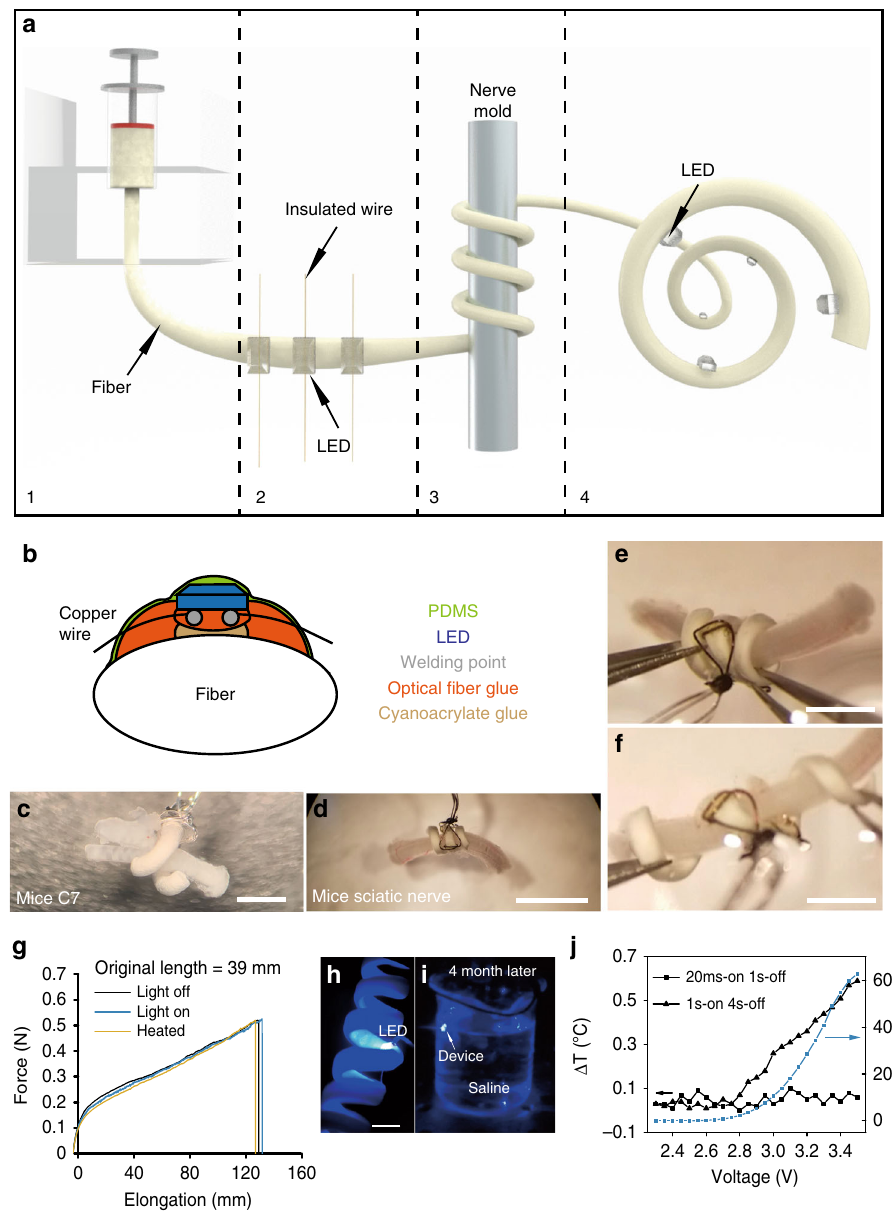
Fig. 2 Fabrication and performance of the multisite optogenetic stimulation device (MOSD). a Flow chart for MOSD fabrication. (1) Production of a polyurethane fi ber; (2) attachment of mini-LEDs to the fi ber; (3) shaping of the fi ber into a spiral shape; (4) fi nal device. b Schematic diagram of device encapsulation. c , d Images of the MOSD wrapped around nerves with different diameters. c Mouse C7 nerve. d Mouse sciatic nerve. e An image of the MOSD at its original length fi xed onto the mouse sciatic nerve. f An image of the elongated MOSD in e . g Mechanical properties of the polyurethane fi ber under light or heat. LED was turned on at 2.5 V, 20.7 µ A (0.0012 mW). The device was kept at 50 °C in the heated condition (green line). The original length of the MOSD is 39 mm. h The MOSD with mini-LEDs turned on in saline. i The MOSD with mini-LEDs turned on after 4 months continuously submerged in saline. j I – V curve as well as temperature changes at different input voltages for the mini-LED. Voltage applied to the mini-LED varied from 2.3 to 3.5 V (0.00003 mW – 33.1 mW). The stimulation patterns for applied voltages are 20 msec-on/2 sec-off and 1 sec-on/4 sec-off. Scale bars are 400 µ m ( c ), 2 mm ( d ), and 1 mm ( e , f Movie 3). 37.5% of the mice did not show movement selectivity. movements in the ankle joint (Fig. 4a). The MOSD was implanted When stimulated with 0.5 – 0.7 mA electrical current for 0.2 msec on the distal side of the sciatic nerve in Thy1 - ChR2 - EYFP mice (Fig. 4e, Supplementary Movie 4), extension in the ankle joint was (Fig. 4b). Prior to the stimulation experiment, the lower limb induced. We also made a MOSD with 4-mini-LEDs (Fig. 4f, inset) stretched naturally, and the knee joint (K), ankle (A) and and turning on all four mini-LEDs for single-site optogenetic metatarsal head (M) were identi fi ed (Fig. 4c). We de fi ned an stimulation (Fig. 4f, Supplementary Movie 5). Flexion in the ankle extension movement as an increase in the K-A-M angle and a fl exion movement as a decrease in the K-A-M angle. Turning on joint was detected. These results demonstrated selective control of fl exion and extension movements in the ankle joint by MOSD mini-LED1 induced fl exion in the ankle joint, whereas turning on stimulation of the sciatic nerve. On the other hand, single-site mini-LED2 alone induced extension (Fig. 4d, Supplementary